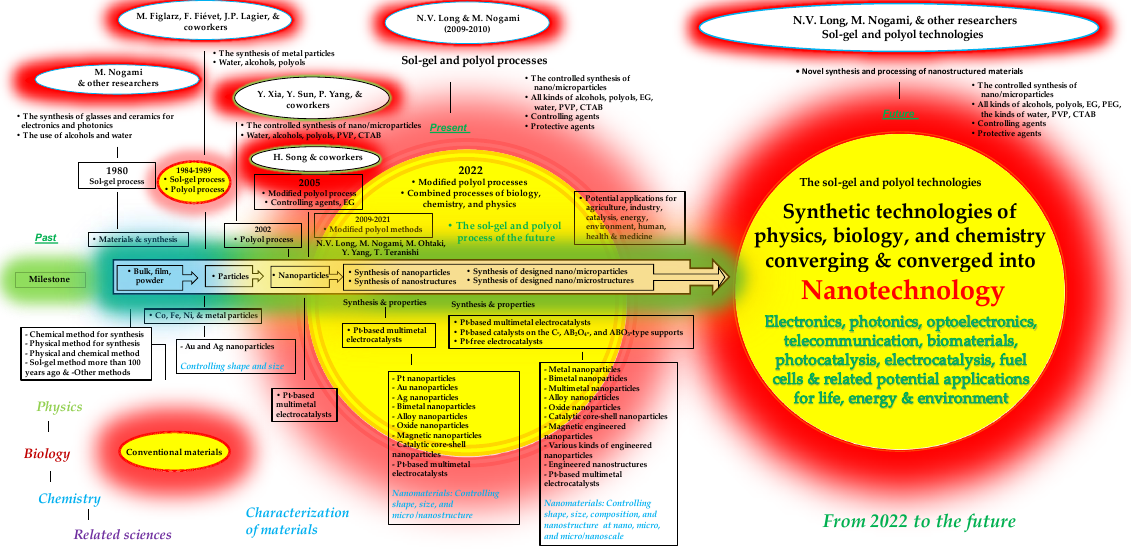
Scheme 2. The polyol process over 30 years. See more: Synthesis of Pt-free or Pt-based electrocatalysts in Figure 3. The combined polyol and sol-gel processes are new, improved, modified, highly efficient, and easy to